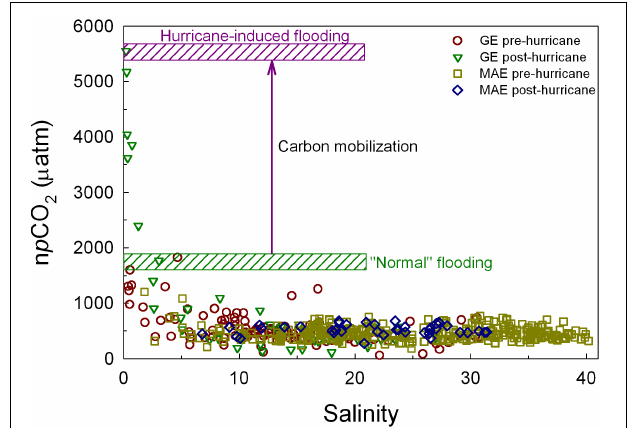
FIGURE 8 | A comparison of temperature normalized p CO 2 (n p CO 2 ) from before and after Hurricane Harvey. The difference between the maximum n p CO 2 values from pre-Harvey flooding periods and that from post-Harvey is considered to be CO 2 signal generated from hurricane mobilized